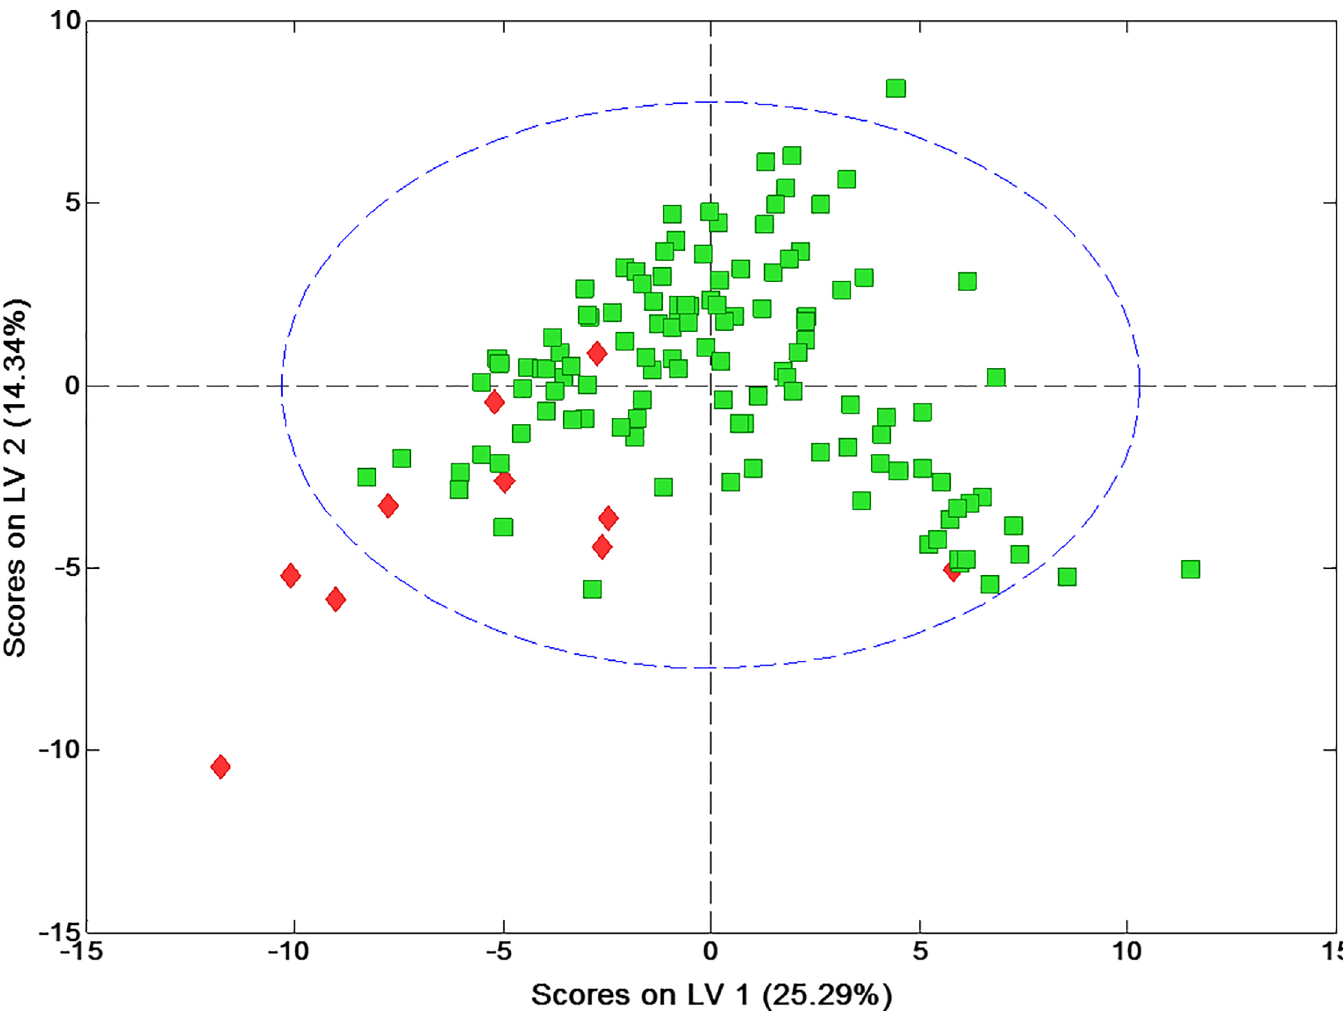
Fig 2. PLS-DA scores to differentiate between patients with GBL (red) and without GBL (green).